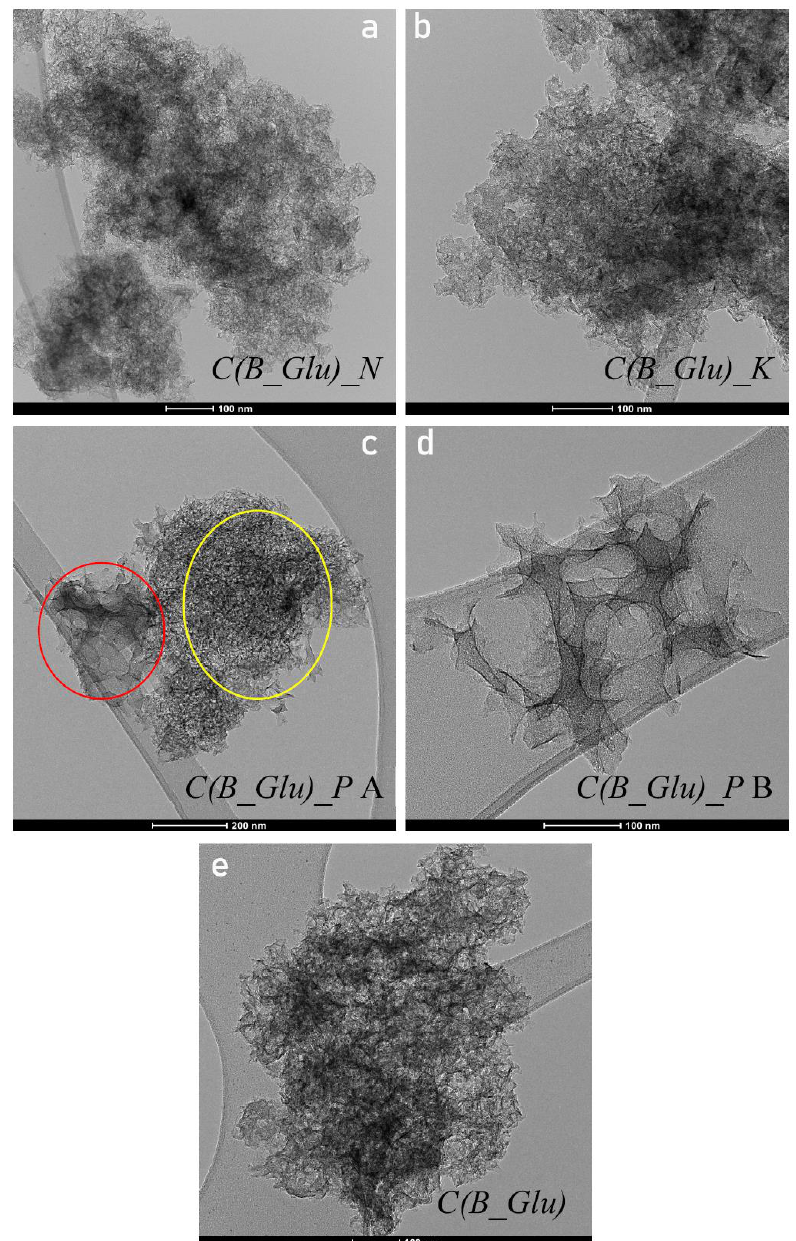
Figure 11. Selected TEM micrographs of the obtained carbons. ( a ) C(B_Glu)_N; ( b ) C(B_Glu)_K; ( c ) C(B_Glu)_P A; ( d ) C(B_Glu)_P B; ( e ) C(B_Glu).